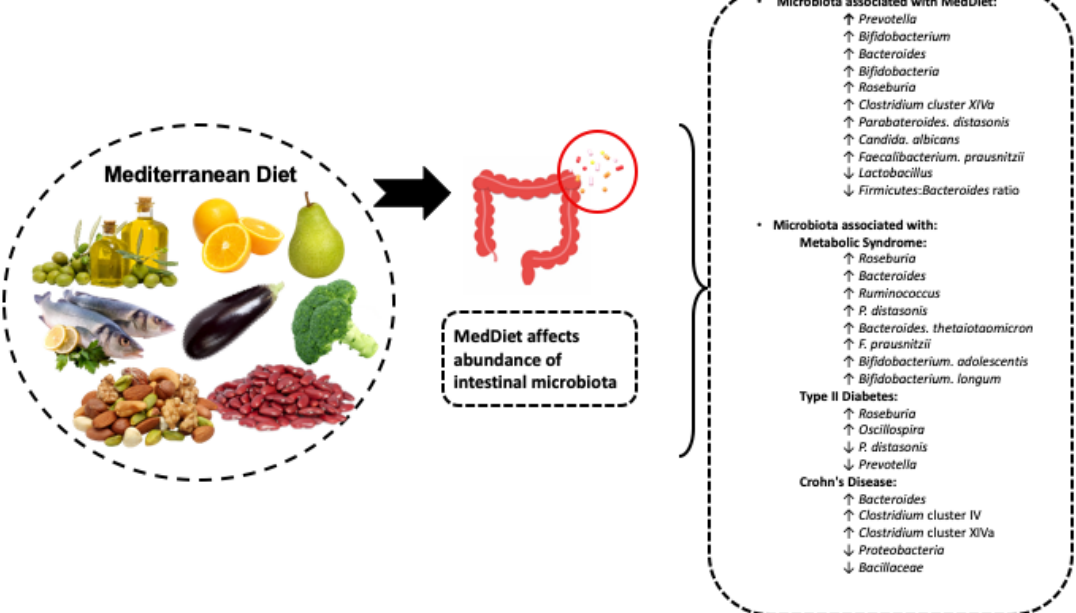
Figure 2. Depiction of the microbiota associated with MedDiet consumption in the absence and presence of disease. All the increases in the microbial changes are identified with an up arrow, and all the decreases are identified with a down arrow. General alterations in the microbiota were only indicated if two or more studies identified that same bacterial change. Research on microbial responses to MedDiet intervention in different disease states is limited, but what has been observed is listed under each respective disease. ↓ : decreased with the consumption of MedDiet. ↑ : increased with consumption of